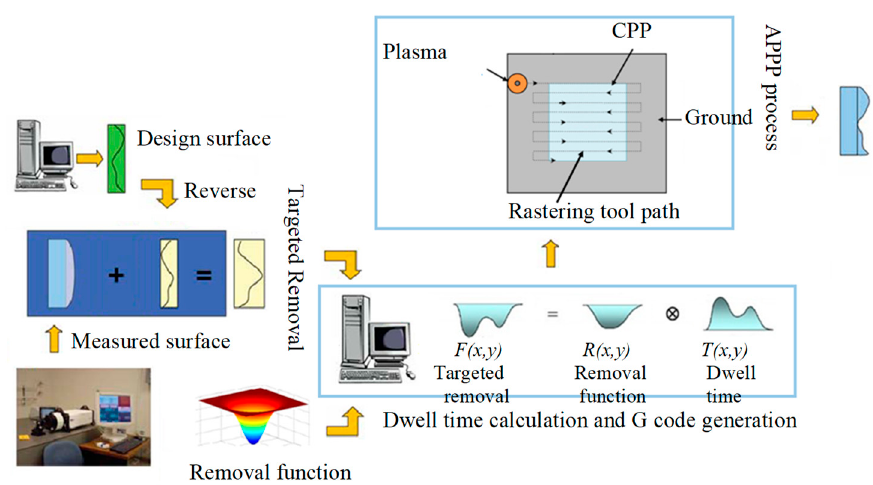
Figure 5. APPP structuring process flow chart.